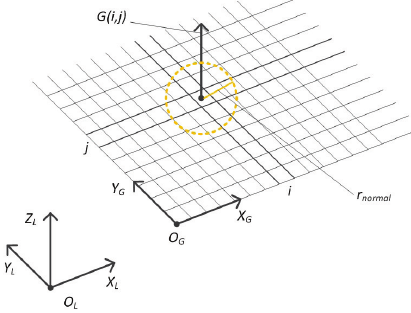
Figure 4. Structure of the 2.5D elevation